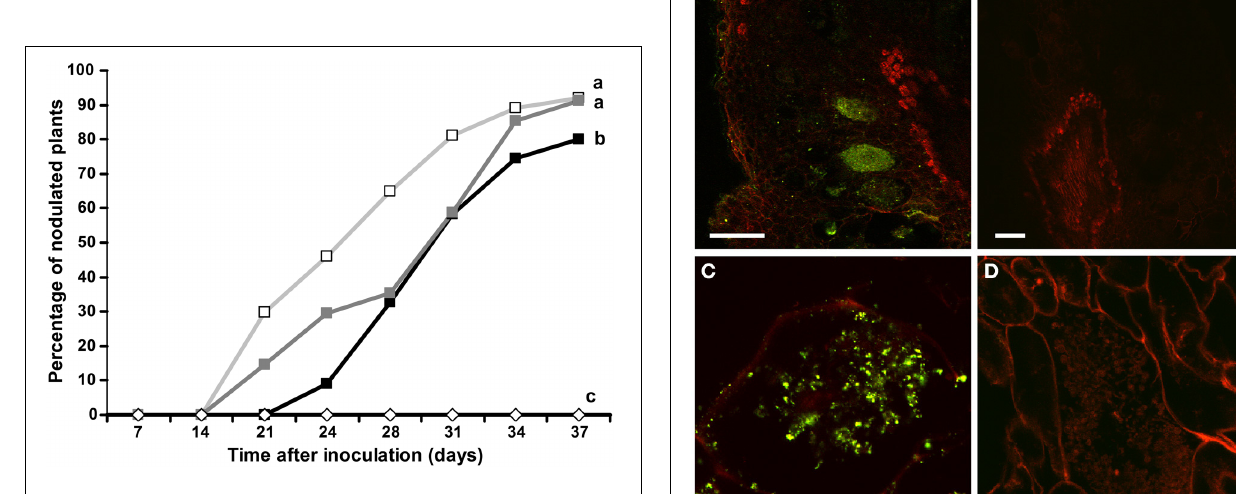
FIGURE 1 | Auxin influx transport inhibitor 1-NOA negatively affects nodulation in D. trinervis . Percentage of plants showing nodules after inoculation with Frankia in the presence of 1-NOA from before inoculation (black line/solid box), from the moment of inoculation (dark gray line/solid squares) or without inhibitor (gray line/empty squares). Nodulation was not observed in non-inoculated control plants (empty diamonds). Letters indicate statistically different groups based on the Tukey-Kramer multiple comparison procedure ( P < 0 . 01).